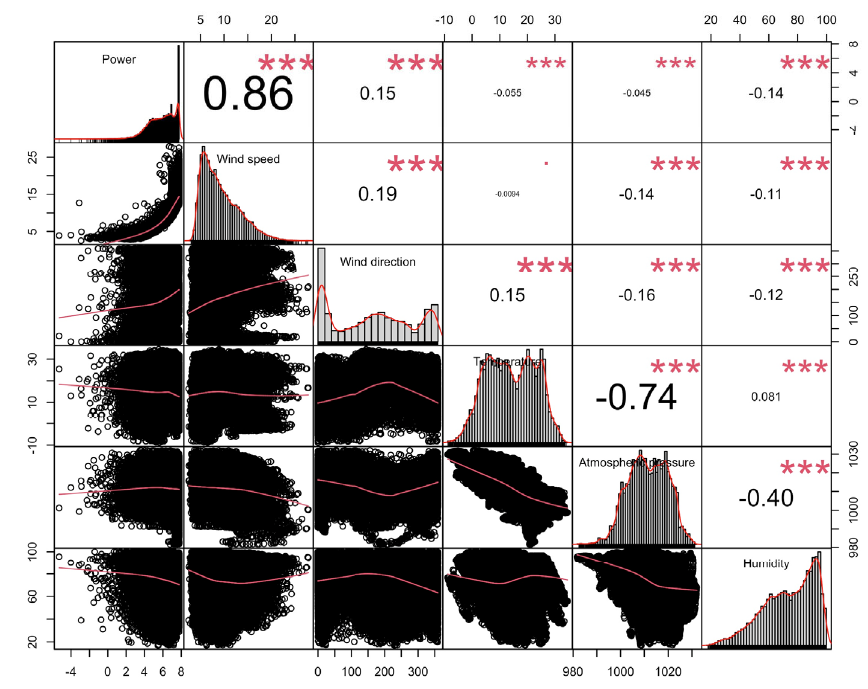
Figure 8. Correlation matrix plot of exogenous variables. (*** p < 0.001; ** p < 0.01; * p < 0.05)